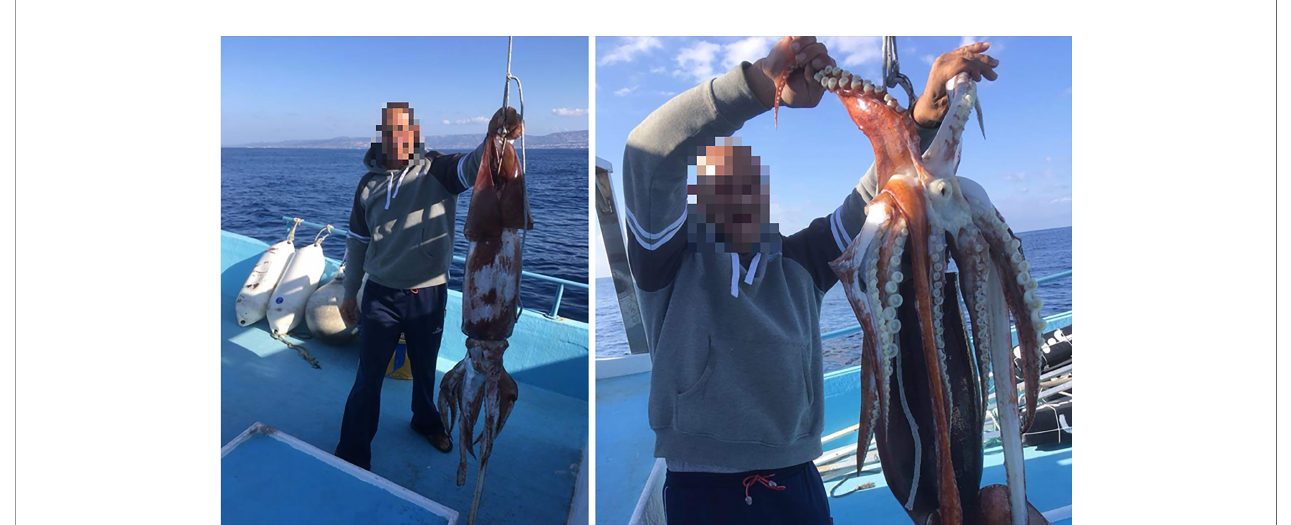
FIGURE 2 | A neon fl ying squid that was incidentally caught on the pelagic longline fi shery in May 2019 when attempting to depredate the albacore tuna.